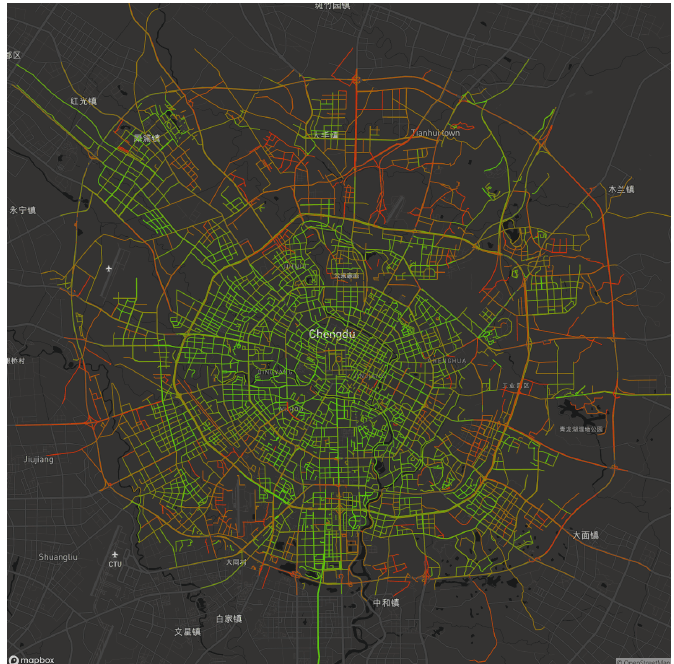
Figure 6. Spatial distribution of the sense of safety in Chengdu. Green indicates higher values of the sense of safety. Streets in red mean low safety